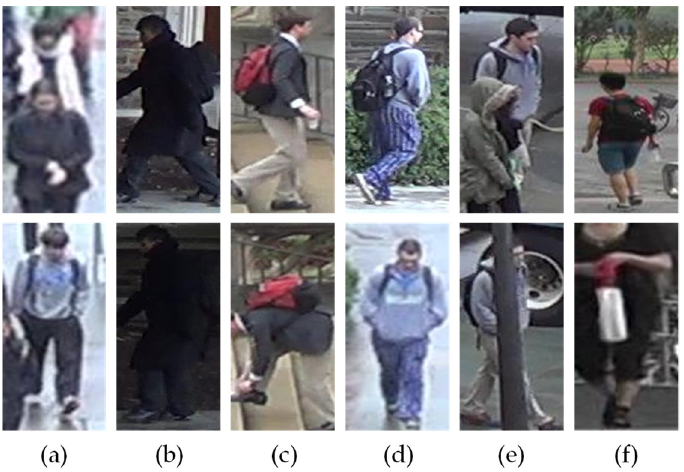
Figure 1. Challenges in ReID tasks. ( a ) low resolution; ( b ) light variations; ( c ) change of posture; ( d ) change of camera view; ( e ) occlusion; ( f ) inaccurate detection.